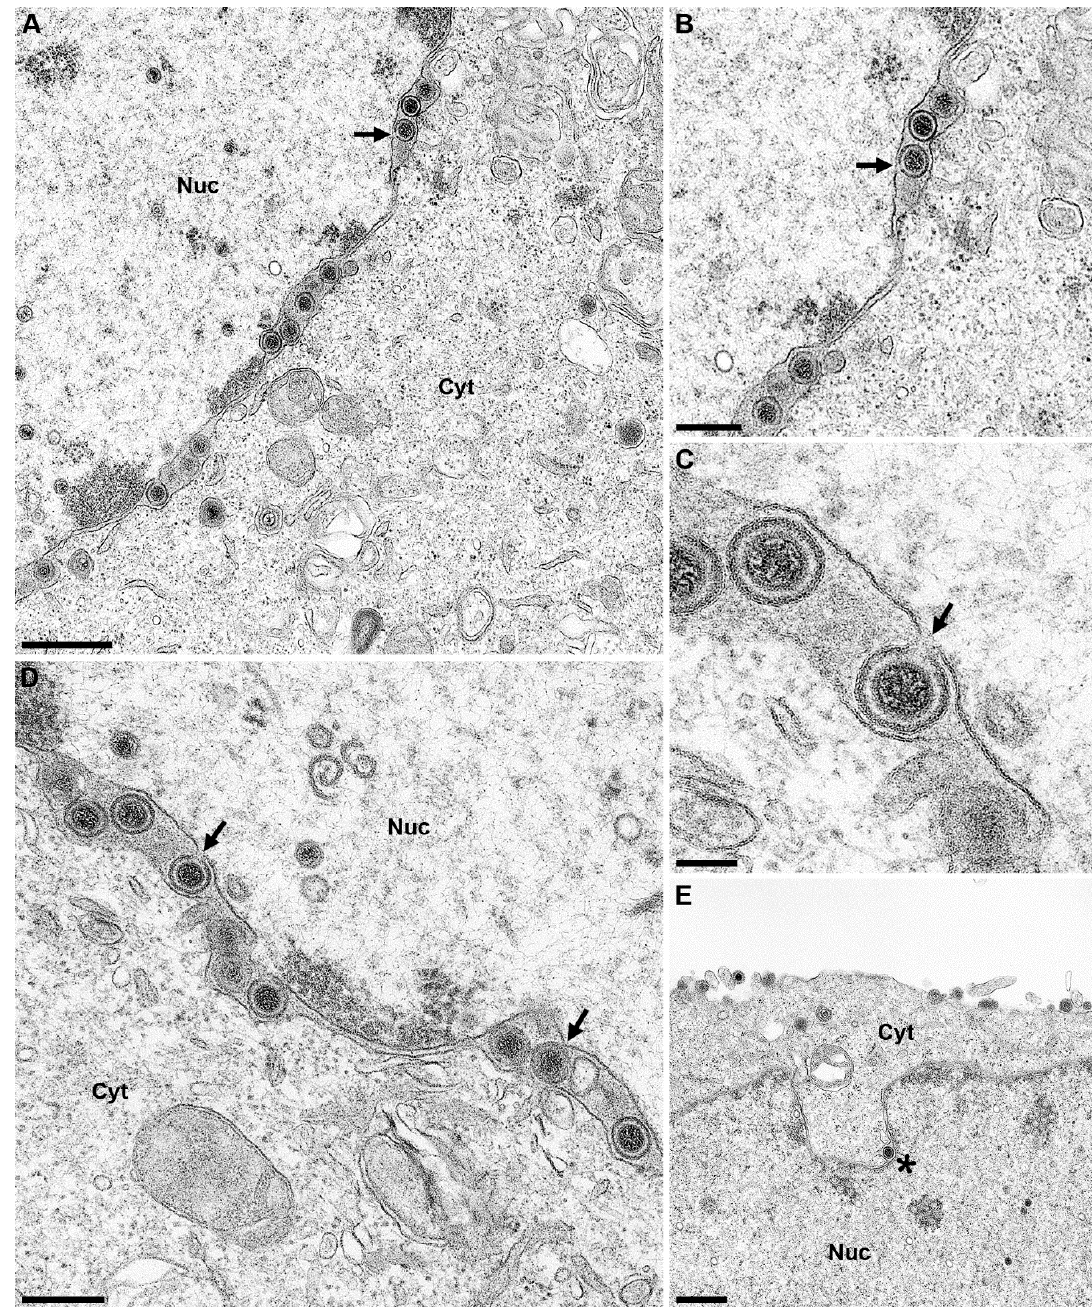
Figure 10. TorA/B DKO results in accumulation of primary enveloped virions in the PNS. RK13, RK13-TorA KO , RK13-TorB KO and RK13-TorA/B DKO cells were infected with PrV-Ka (MOI of 1) and processed for electron microscopic imaging 14 h p.i. No obvious effect was found for the single KO cells (data not shown), while the TorA/B DKO showed accumulations of primary virions within the PNS, many of them still connected to the INM by a short neck (indicated by arrows) ( A – D ). Panel ( B ) shows a higher magnification of the infected cell in panel ( A ), while panel ( C ) shows a higher magnification of panel ( D ). Panel ( E ) shows a rare case of a primary virion in the PNS in parental RK13 cells (marked by asterisk). Scale bars indicate 600 nm in panel (A,E), 300 nm in panel (B,C) and 100 nm in panel (D). Nuc: nucleus, Cyt: cytoplasm.